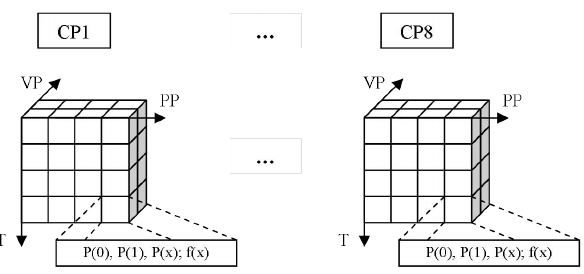
Fig. 7. Parameter set of a CP-based MRC for each combination of cell properties as a four-dimensional matrix. The small cubes con- tain the parameters for the branching of a parent cell with given cell properties CP (circulation pattern class), VP (volume property), PP (position property) and T (timescale property). A template of pa- rameters for a branching with b = 2 is shown for the highlighted cube. The parameters are the probabilities P of states W = 0, W = 1 and W = x , and the empirical probability distribution function f (x) for the state W = x .